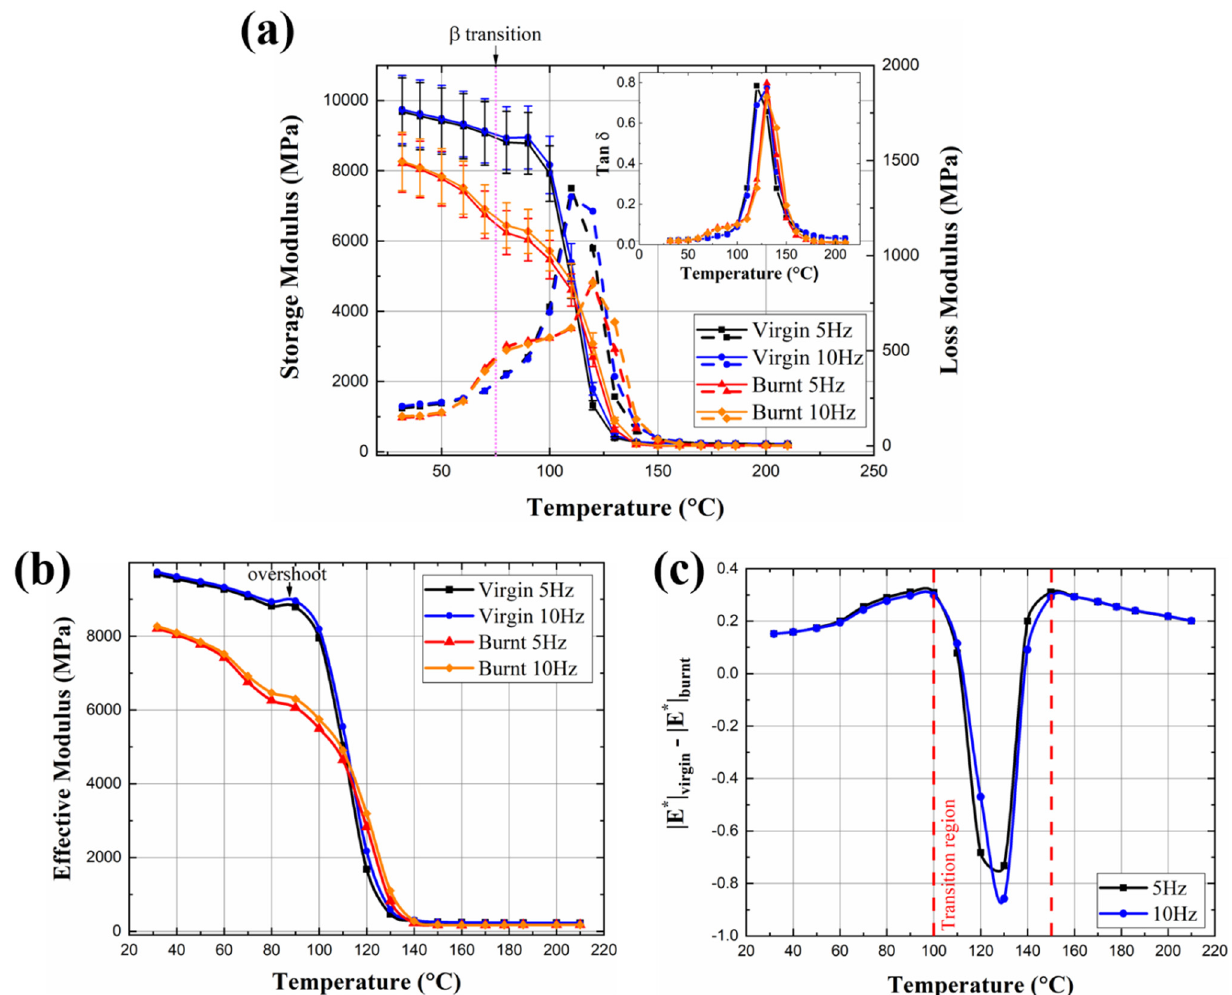
Figure 1. ( a ) Thermomechanical spectra plotting the storage and loss moduli; ( b ) magnitude of the effective moduli, and ( c ) percent change in the magnitude of the effective moduli of virgin and burnt specimens as a function of temperature at 5 and 10 Hz.